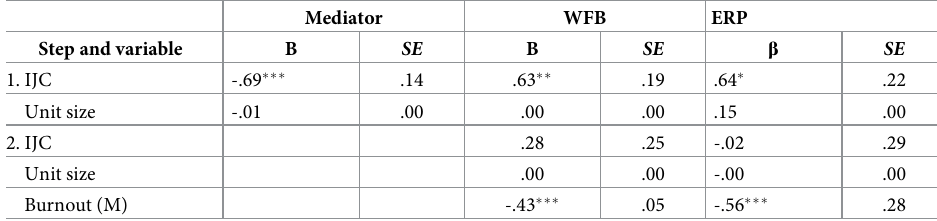
Table 2. The results for burnout hierarchical regression models.